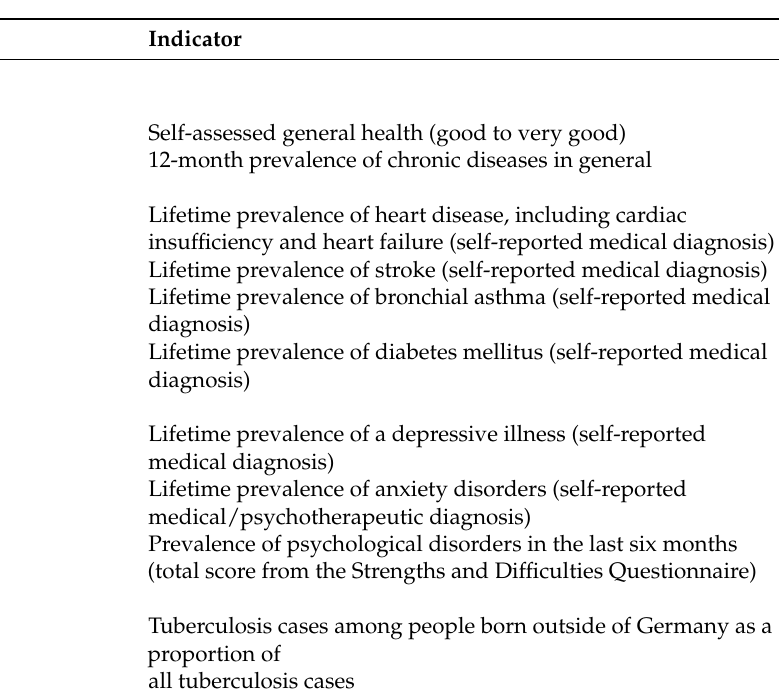
Table 2. Core indicators developed within the IMIRA project to describe the health of people with migration background in public health reporting (adapted from